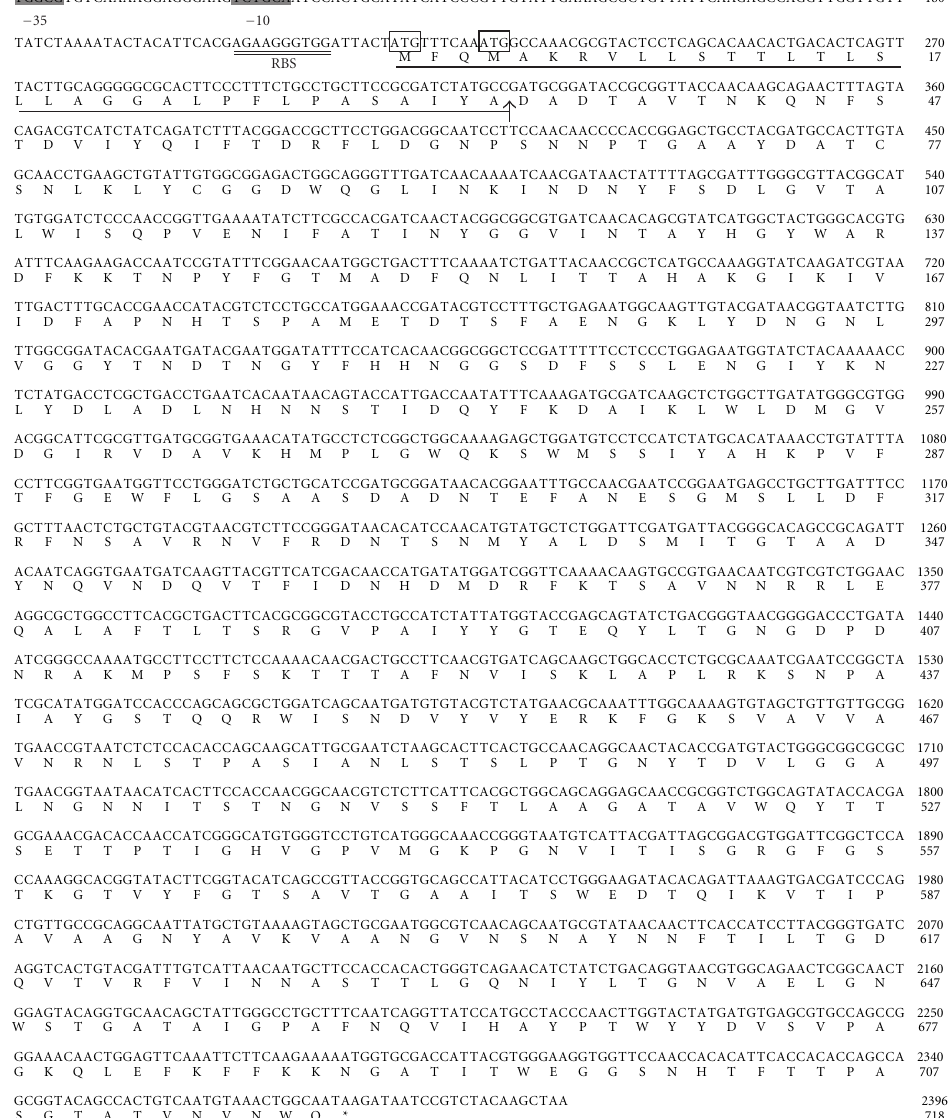
Figure 1: Nucleotide and deduced amino acid sequences of the CGTase of Paenibacillus pabuli US132. The putative ribosome-binding site (RBS) is double underlined. The putative promoter regions ( − 10 and − 35) are shaded. The two possible initiator codons are boxed. The underlined amino acid sequence was the predicted signal peptide and the vertical arrow indicated the possible signal peptide cleavage site. Full nucleotide and amino acid sequences data reported in this paper were submitted to the GenBank under the accession number